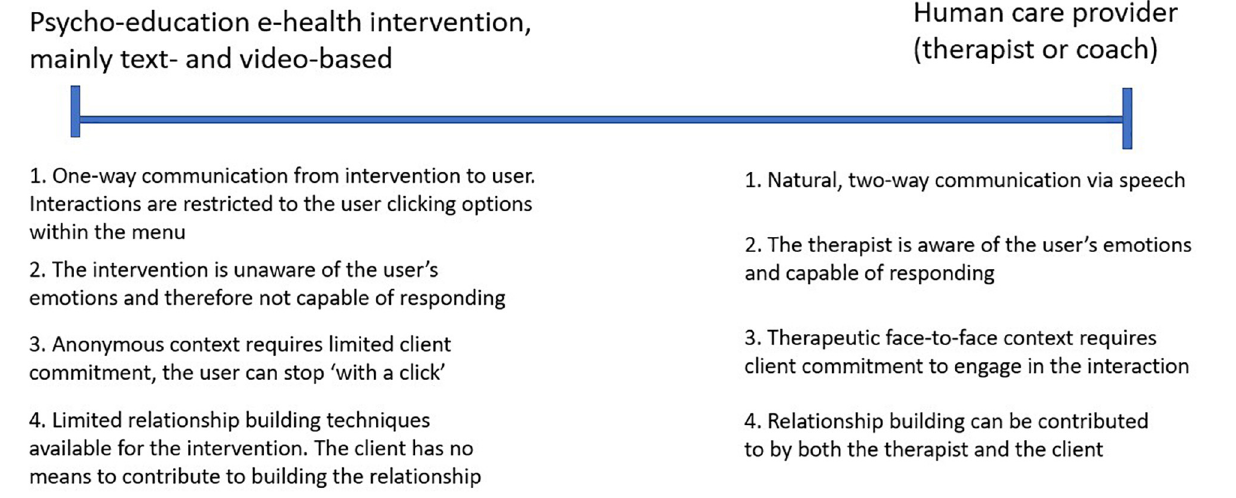
FIGURE 1 | The left and right boundaries for ECA’s as adjuncts in e-mental